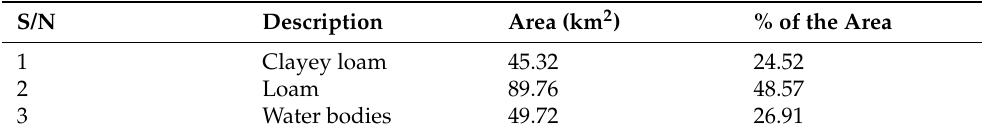
Table 5. Data on soil composition.